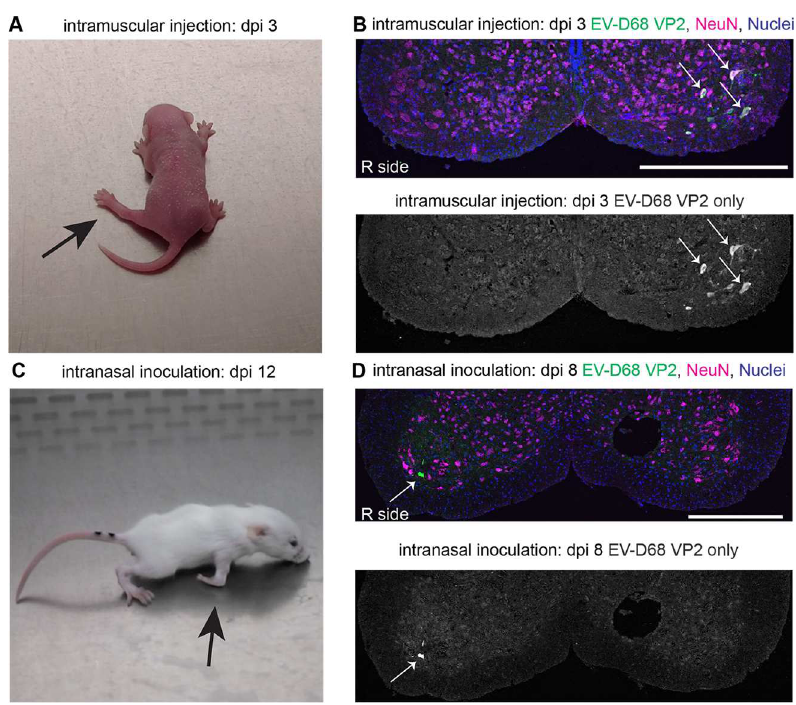
Fig 5. EV-D68 causesparalysis after intranasal and intramuscular infection. ( A ) An image of a day 3 post-infection mouse with new onset left hindlimbparalysisfollowingintramuscular injectionof EV-D68 strain MO/14-18947. ( B ) Lumbarspinal cord sections (100X originalmagnification) from an intramuscular-injected mouse at day 3 post-infection with left hindlimbparalysisshowingloss of motor neuronsand viral antigen (arrows) in the left anterior horn. ( C ) An image of a mouse on day 12 post-infection that developed right forelimbparalysisfollowingintranasal infection with EV-D68 strain MO/14-18947. ( D ) Cervical spinal cord sections(100X originalmagnification) from a day 8 post-infection intranasal-infectedmouse with right forelimb paralysisshowingviral antigenin the anterior horn (white arrow). The scale bars are 400 μ m. Abbreviation: dpi, days